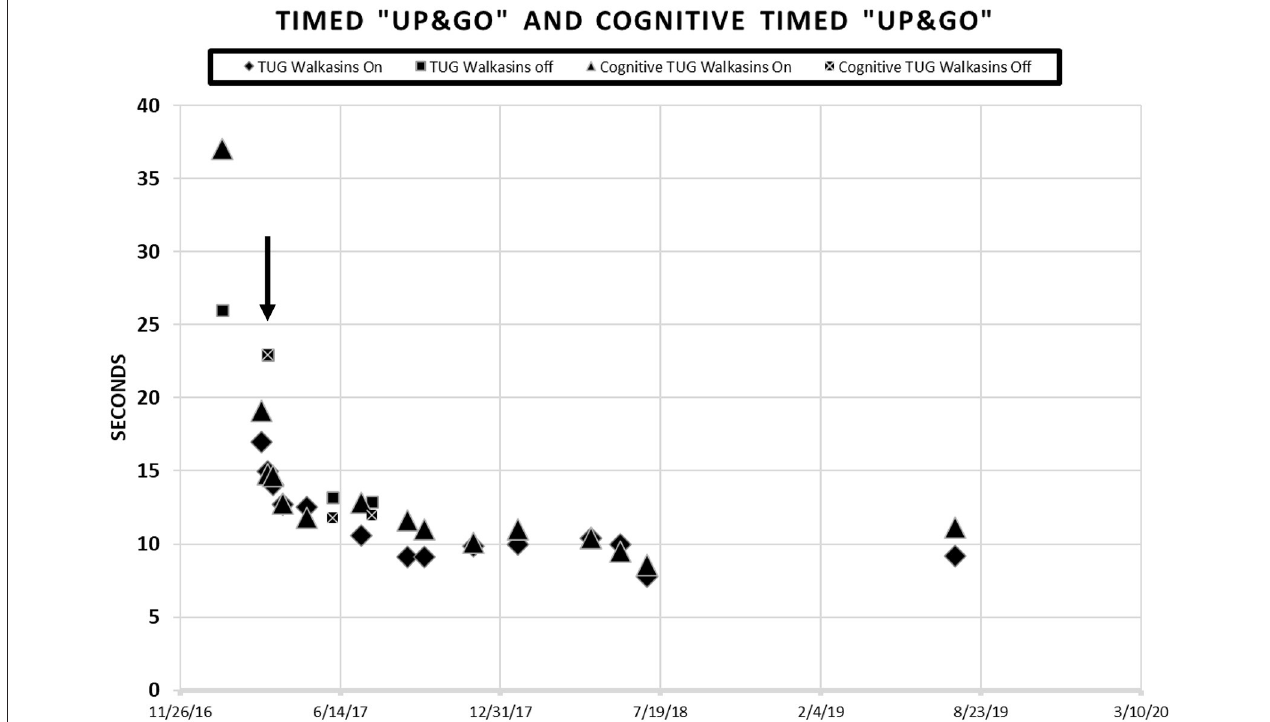
FIGURE 2 | Patient scores on the Timed “Up & Go” and the Cognitive Timed “Up & Go” in seconds prior to and during intervention with the Walkasins ® . He started wearing the Walkasins ® 3/8/17 as indicated by the arrow ↓ . Note some days were tested while wearing the device and some were not. When the tests were performed without the Walkasins ® , the patient had not used them for 1